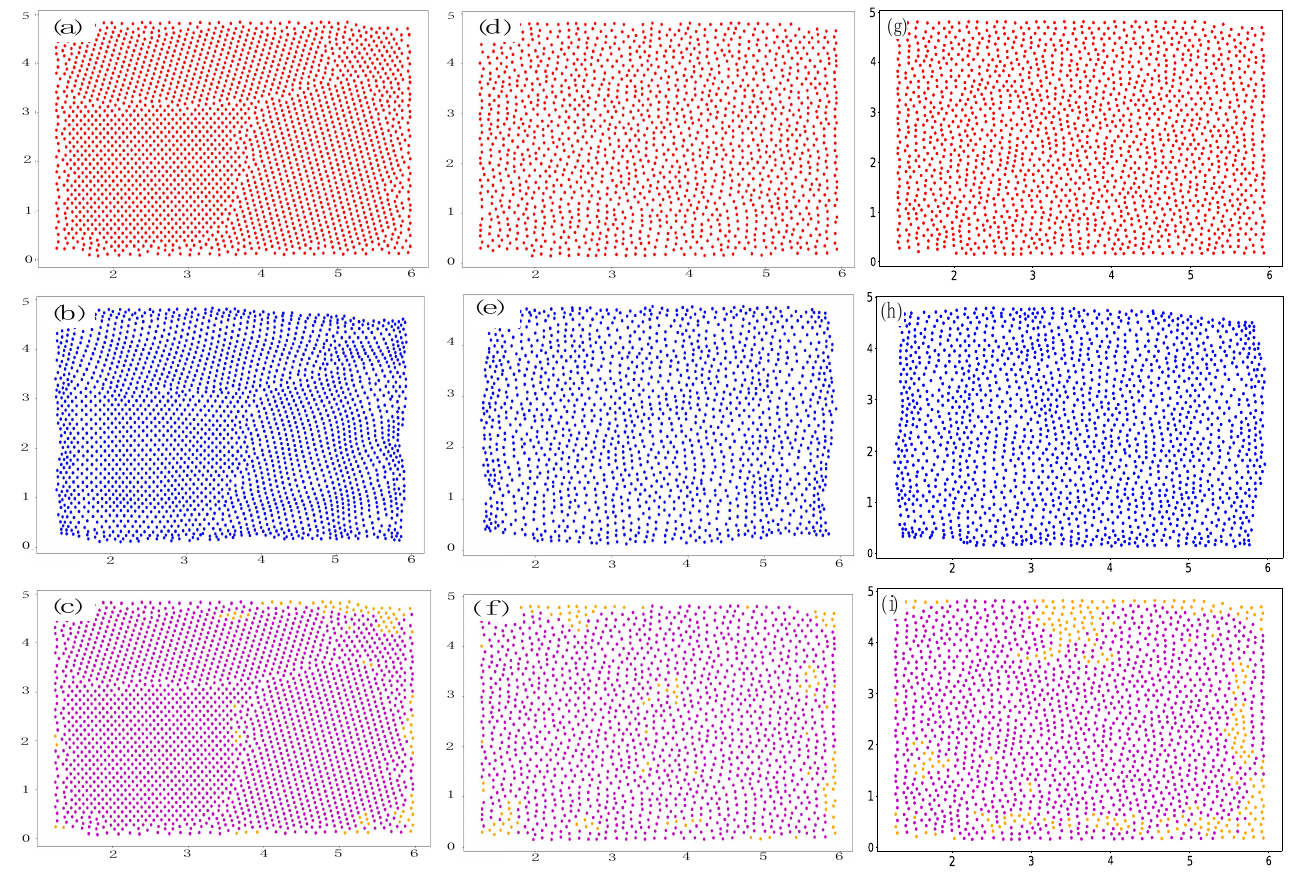
Figure 6. Granular system coordinate diagram, coordinate prediction diagram, and comparison diagram. The red particle map is the original coordinate map of the granular system, the blue particle map is the prediction map, the magenta particles are the effective prediction particles, and the orange particles are the ineffective prediction particles. Moreover, ( a – c ) show the 1:0 granular system where the RMSE is 0.0302 and the EPA is 95.78%; ( d – f ) show the 1:1 granular system where the RMSE is 0.0357 and the EPA is 93.1%; and ( g – i ) show the 2.16:1 granular system where the RMSE is 0.0417 and the EPA is 85.6%.